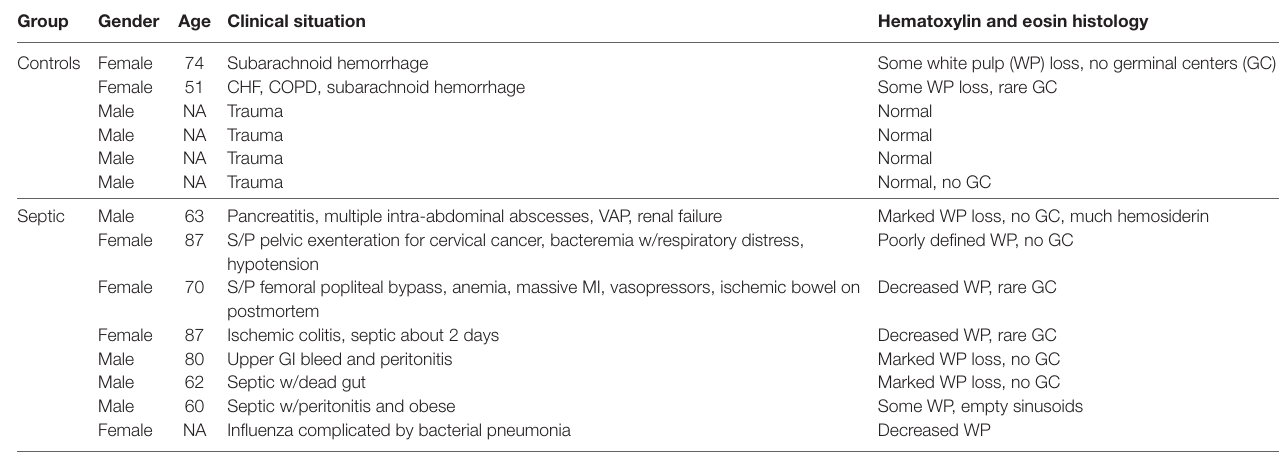
Table 1 | Patient profiles.